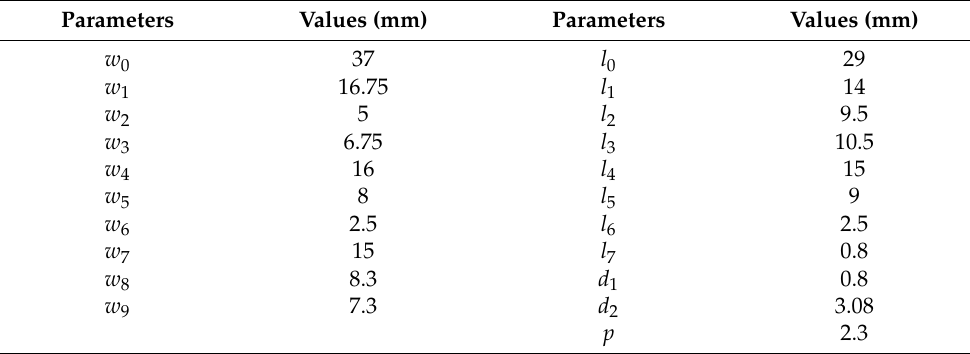
Table 1. Design parameters for the proposed array